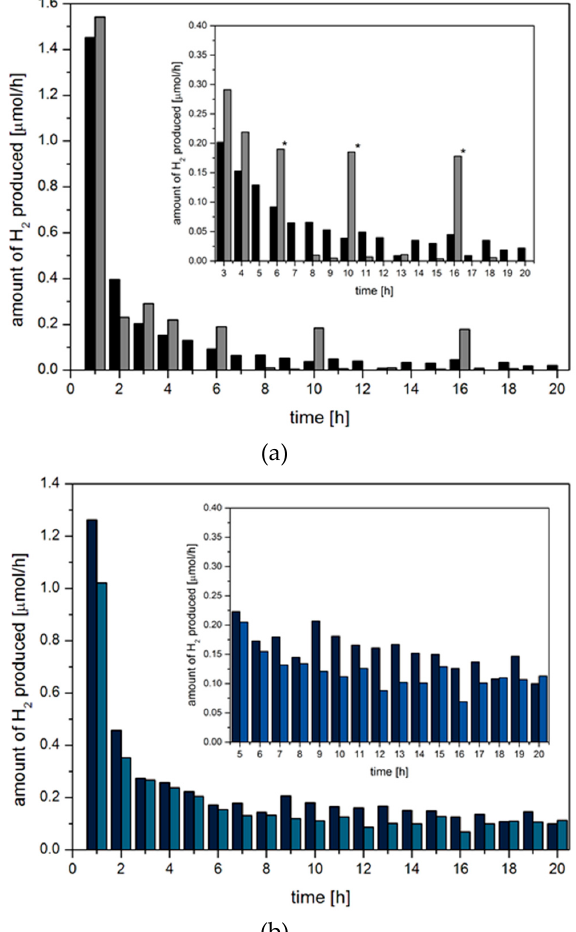
Figure 6. Amounts of hydrogen produced per hour within the first 20 h of irradiation using a multicomponent system containing the degrading dye 3 ( a ) and the stable dye 4 ( b ). Two columns for each system show results from two independent experiments. The insets show an enlarged section of the graph illustrating the different behaviour of degrading and stable dyes. The asterisks mark outliers that originate from internal mistakes of the volume correction during measurements.